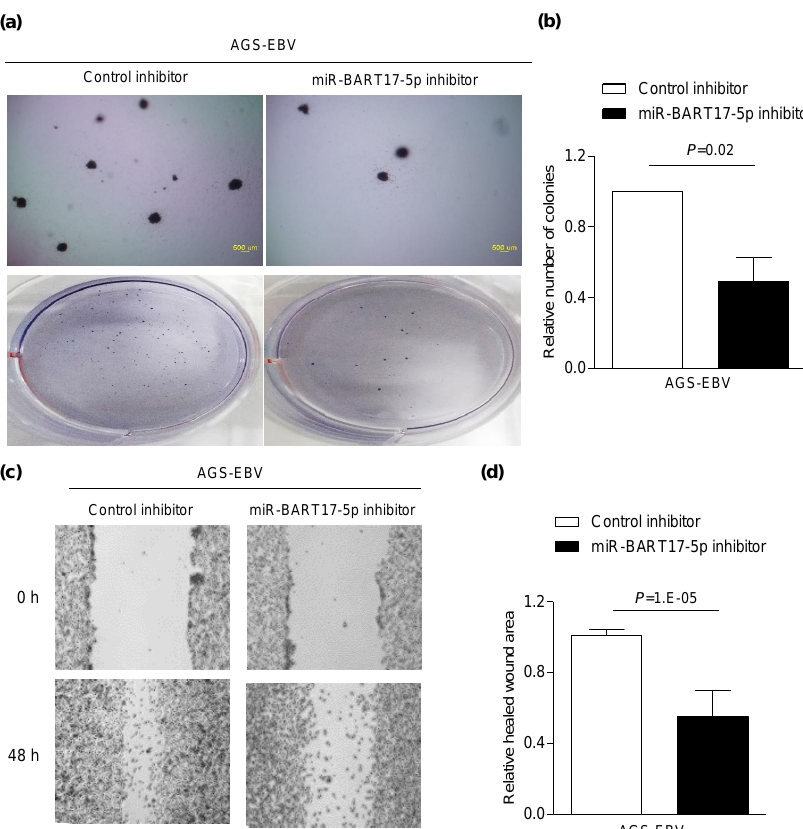
Figure 5. Suppressed AGS-EBV cell migration and anchorage-independent growth by the miR-BART17-5p inhibitor. AGS-EBV cells were transfected with the miR-BART17-5p inhibitor and all experiments were conducted three times independently ( a – d ). ( a ) To conduct soft agar colony formation assay, the transfected AGS-EBV cell was harvested after 24 h and seeded in agar. Cells placed in agar were observed after 4-6 weeks. All experiments were conducted three times. Upper panels were observed with microscope IX70 through a × 40 objective. Lower panels show the pictures taken with a camera. ( b ) Colonies were quantified using Image J software. Error bars indicate SD ( n = 3). ( c ) Wound-healing assay was performed using AGS-EBV cells transfected with either the miR-BART17-5p inhibitor or the control inhibitor in three independent experiments. ( d ) Healed wound area was measured by Image J software. Error bars indicate SD ( n =